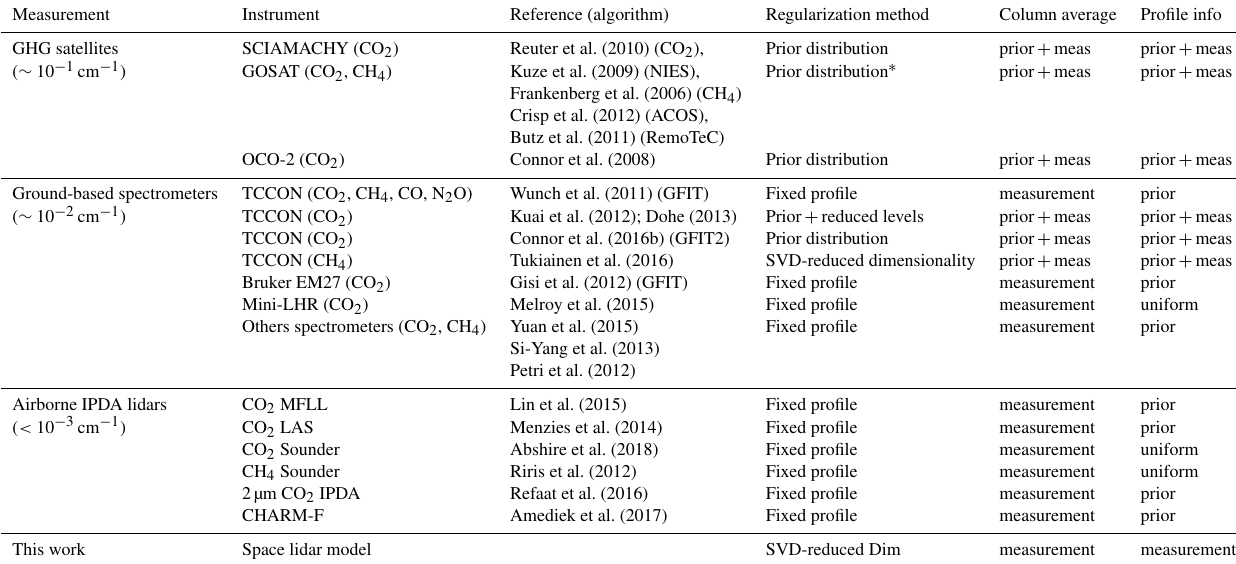
Table 1. Comparison of retrieval algorithms used for GHG remote sensing based on regularization method and source of vertical information. The approximate spectral resolution (instrument linewidth; see Sect. 4.4), is given in brackets for each type of measurements. The SVD method proposed in this work extracts information on the vertical GHG distribution strictly from the measurement, making no assumption of a prior distribution. Note that use of a uniform column for vertical information is equivalent to the use of an uninformative prior. ∗ Butz et al. (2011) used the prior distribution for regularizing the CO 2 retrievals but the SVD-reduced dimensionality for CH